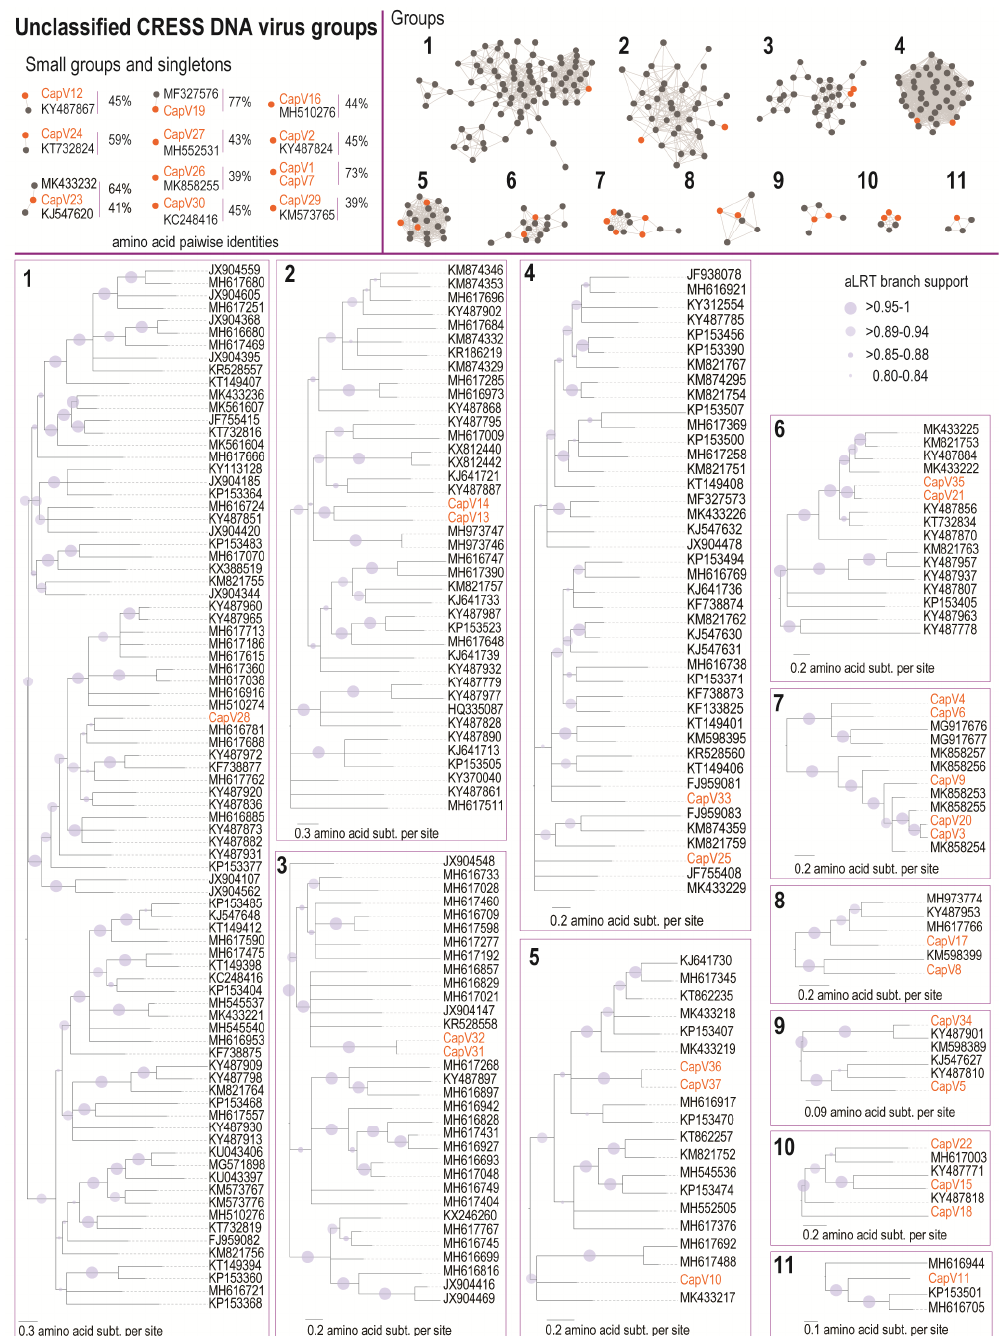
Figure 4. Sequence similarity network analysis and maximum likelihood phylogenetic trees of the Rep amino acid sequences of the unclassified CRESS viruses associated with the capybara. Orange dots represent the Rep of the unclassified CRESS DNA viruses identified in this study. The capybara viruses 1–37 are highlighted in orange, and branches with aLRT support < 0.8 have been collapsed.